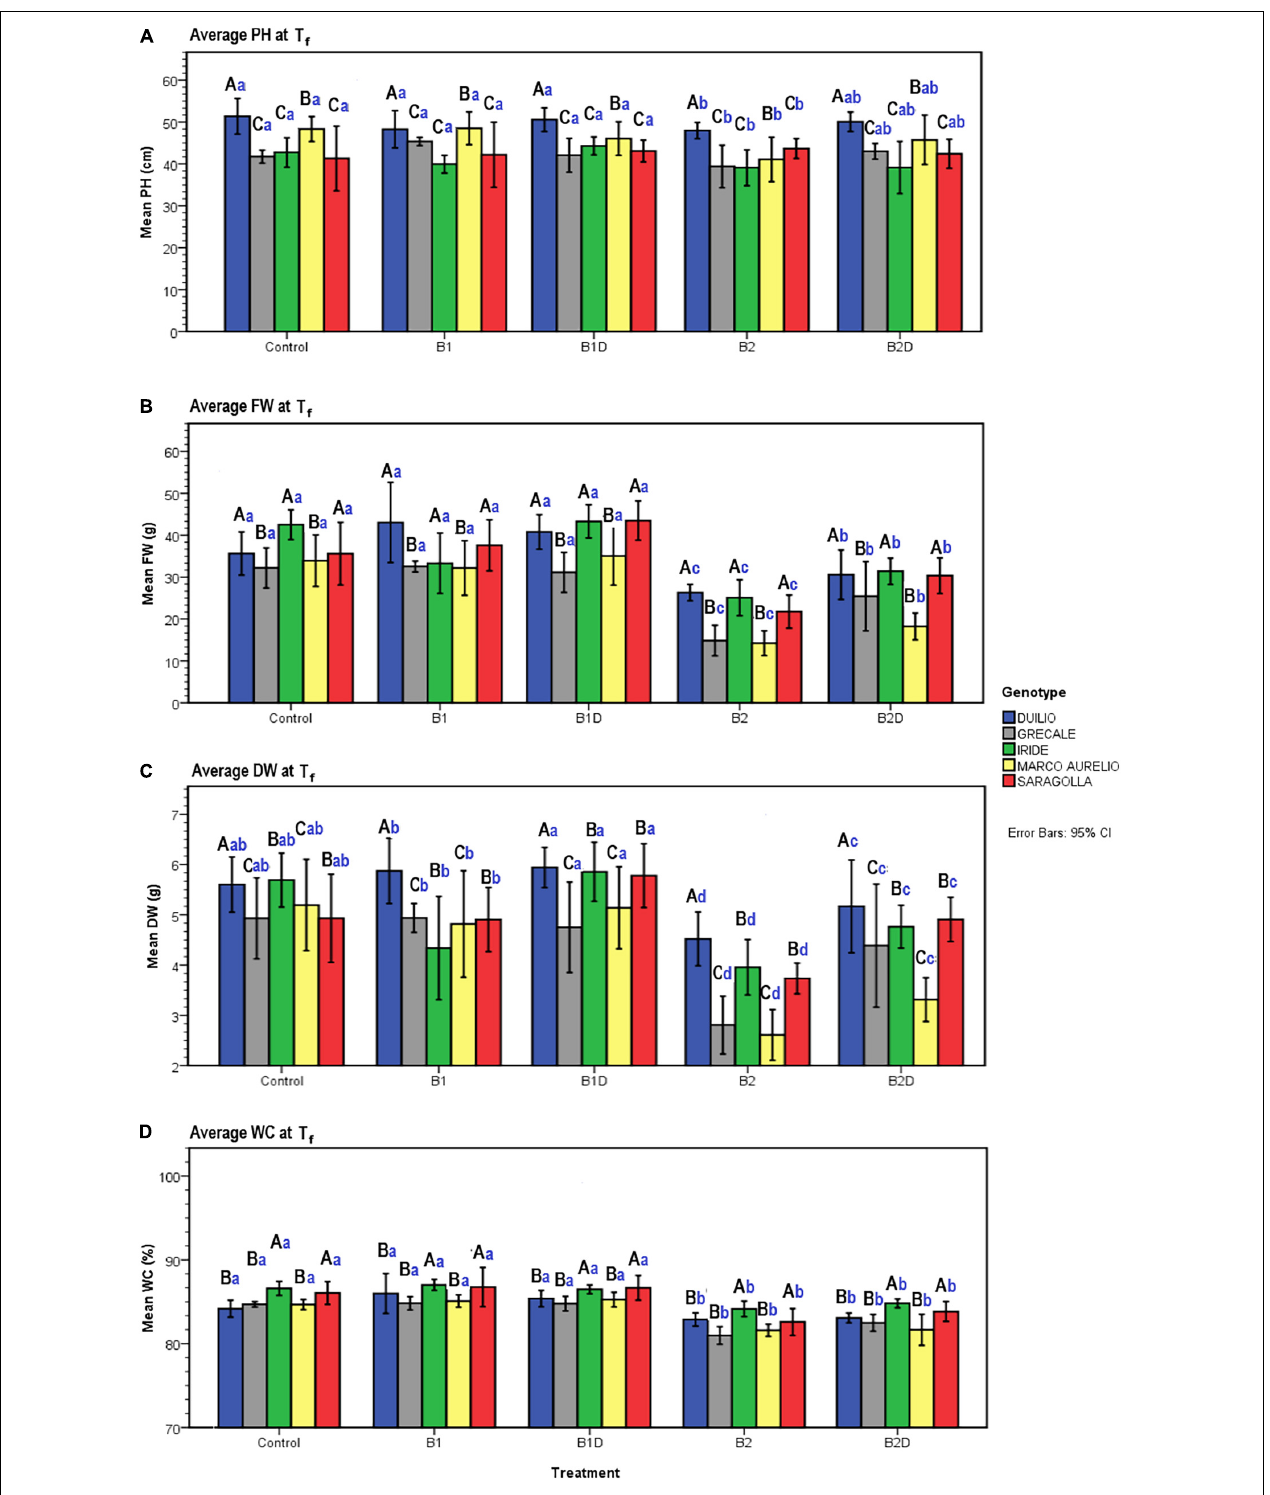
FIGURE 5 | (A) Plant height (PH), (B) plant aboveground fresh weight (FW), (C) dry weight (DW), and (D) water content (WC ) measured data at T f as a function of genotype and treatment. Bars represent mean values, with error bars denoting 95% confidence intervals (CI). Different bold letters indicate significant difference according to the Ryan-Einot-Gabriel-Welsch-and-Quiot (R-E-G-W-Q) test at the p < 0.05 level for PH and DW and at the p < 0.01 level for FW and WC, with the black uppercase letters referring to the “genotype” subset and the blue lowercase ones to the “treatment” subset.